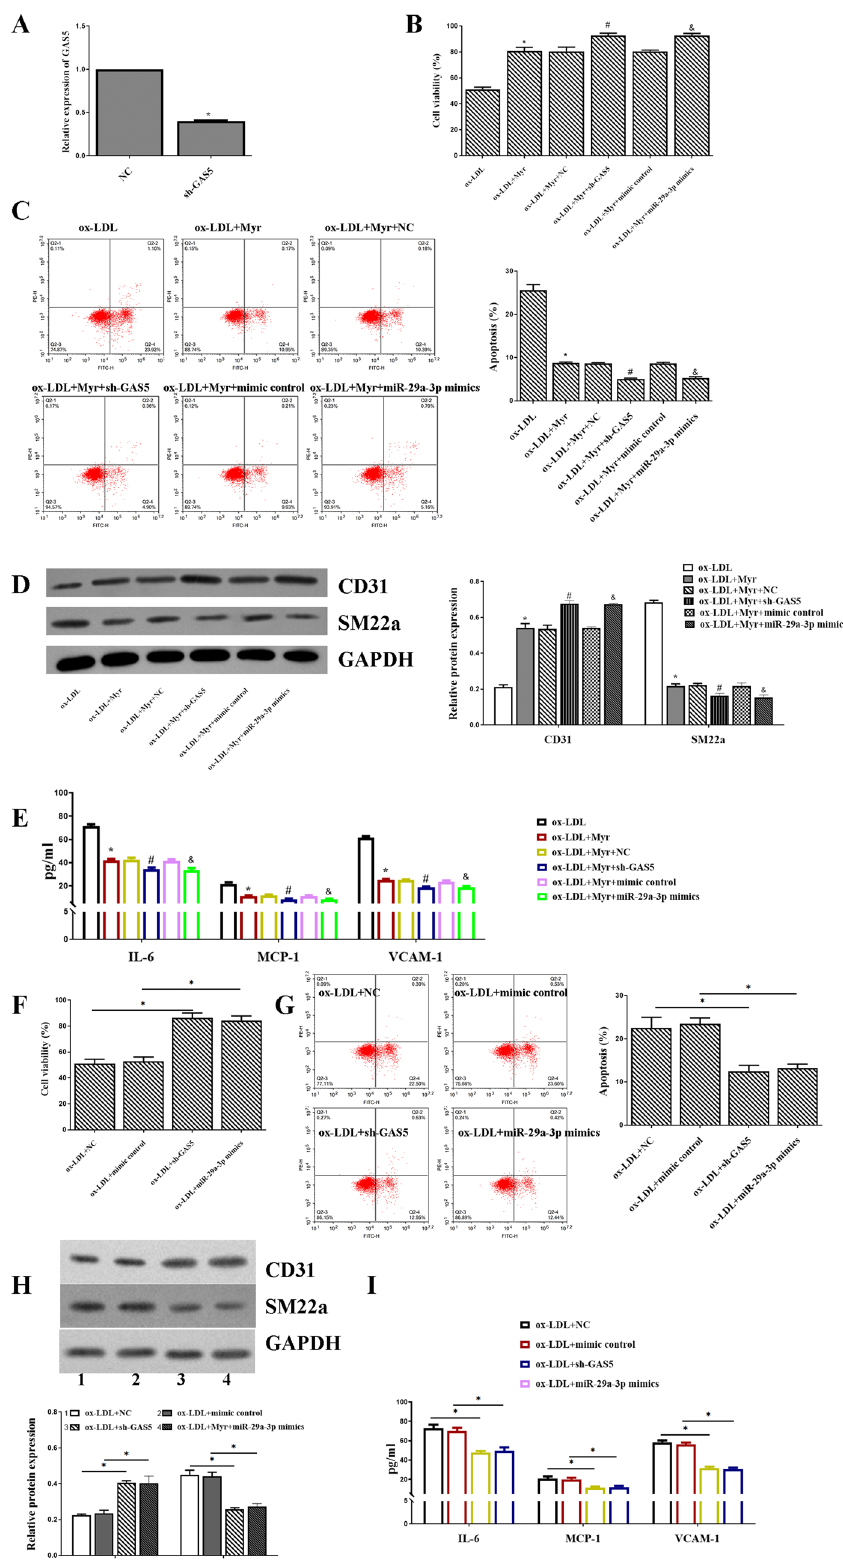
Figure 6. sh-GAS5 or miR-29a-3p mimics can accelerate the protective role of Myr in ox-LDL-induced HUVECs cell. ( A ) The expression of GAS5 after inhibiting GAS5. ( B , F ) Cell viability was detected by MTT assay. ( C , G ) Flow cytometry assay was used to test apoptosis analysis. ( D , H ) Western blot analysis of CD31 and SM22a expression in HUVEC cells. ( E , I ) The protein levels of IL-6, MCP-1 and VCAM-1 were detected by ELISA assay. * P < 0.05 compared with ox-LDL; # P < 0.05 compared with ox-LDL + Myr + NC. & P < 0.05 compared with ox-LDL + Myr + mimic